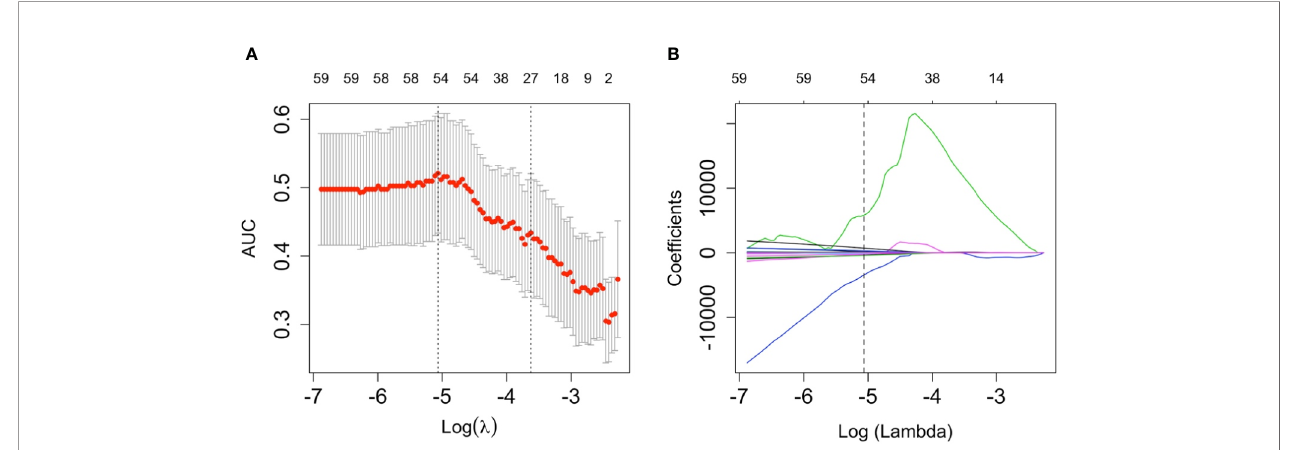
FIGURE 2 | The least absolute shrinkage and selection operator (LASSO) logistic regression algorithm was employed to determine the most signi fi cant radiomics features in terms of microvascular invasion (MVI) prediction as well calculated for the Rad-score. (A) a ten-fold cross validation method was employed to select the optimal lambda parameter contained in the LASSO algorithm that minimized the mean squared error. The mean-squared errors between upper bound and lower bound standard deviations were plotted according to the lambda changing sequence. The vertical dotted lines in the graph stands for the two selected lambdas. The lambda on the left corner of graph provided the minimum mean cross-validation error, meanwhile, the lambda on the right corner of graph provided the most optimal regularized model which the error within one minimal standard error, therefore, the optimal lambda value 0.0063, whose log(lambda)= -5.0637, was employed to feature selection. (B) A coef fi cient pro fi le plot of the LASSO model was produced. Every single curve represents the trajectory changing of each independent predictor. The greater lambda is, the more the coef fi cients are reduced. The vertical dotted line indicates the optimal lambda, which results in two coef fi cients.